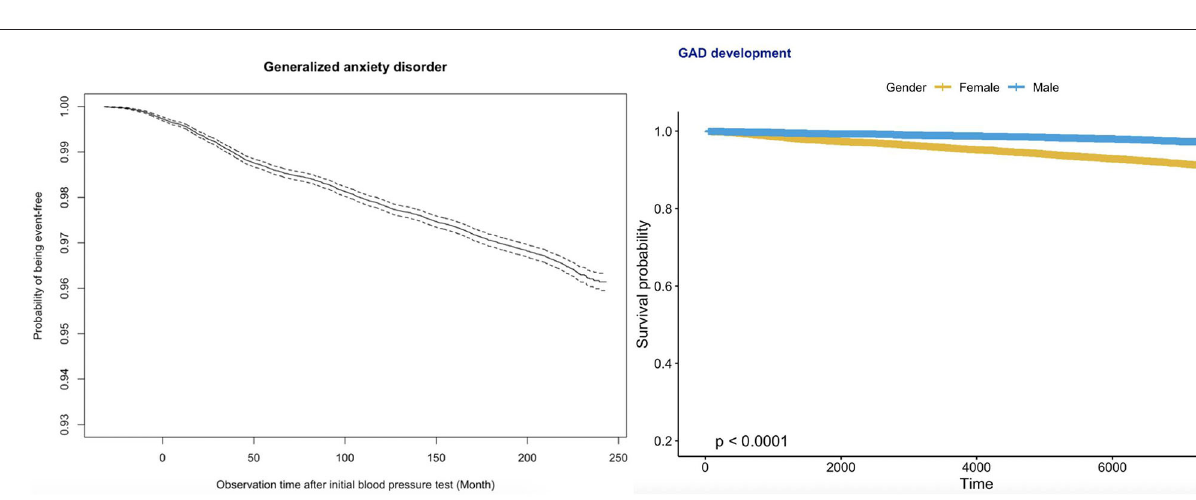
among those over 30 years of age. Kaplan–Meier survival